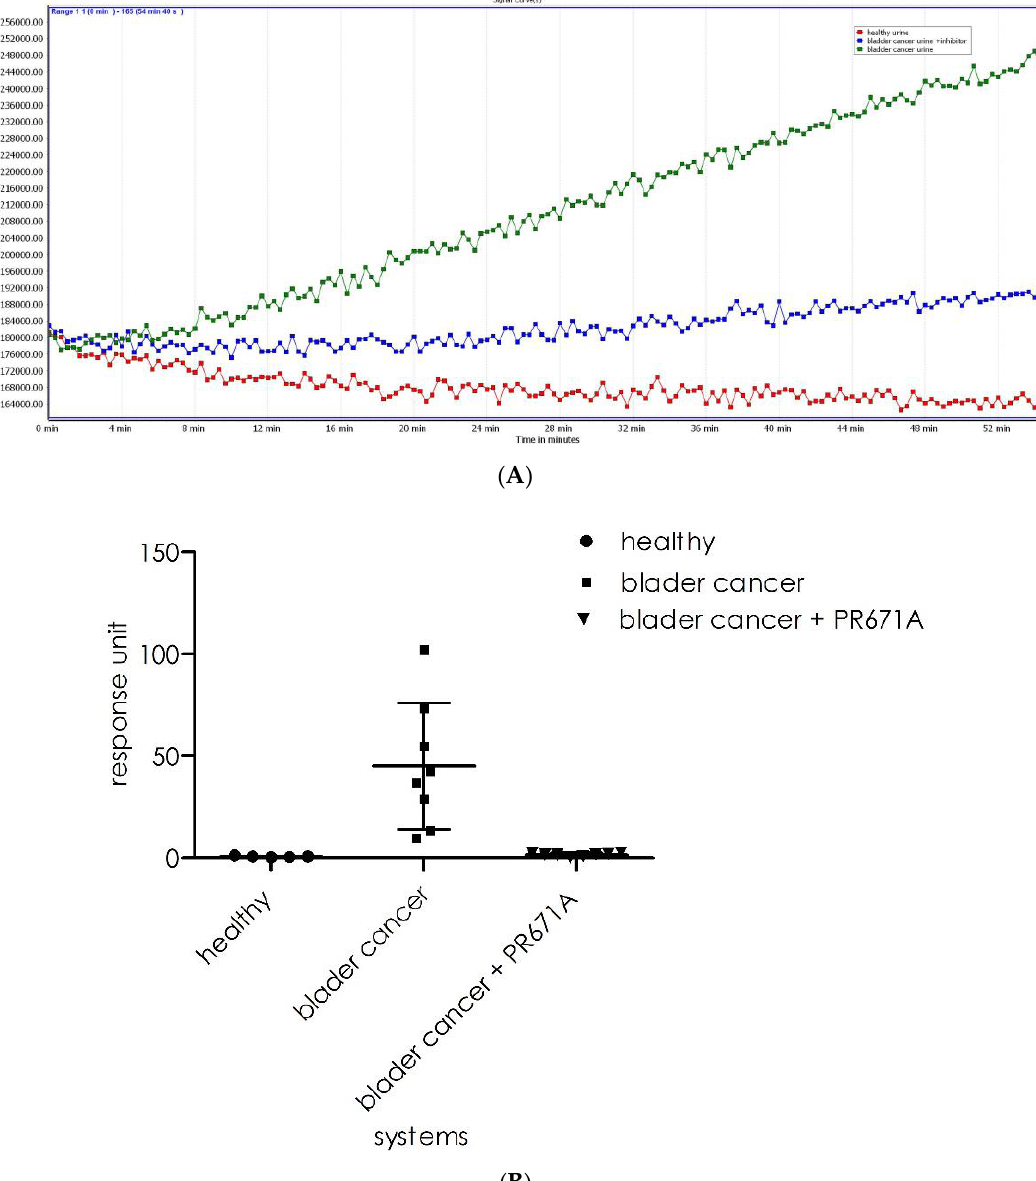
Figure 10. ( A ) Fluorescence curves for the three the systems: healthy urine (red line), bladder cancer urine (green line), and inhibitor-treated bladder cancer urine (blue), ( B ) aggregate analysis of the healthy and bladder cancer urine and inhibitor-treated urine.